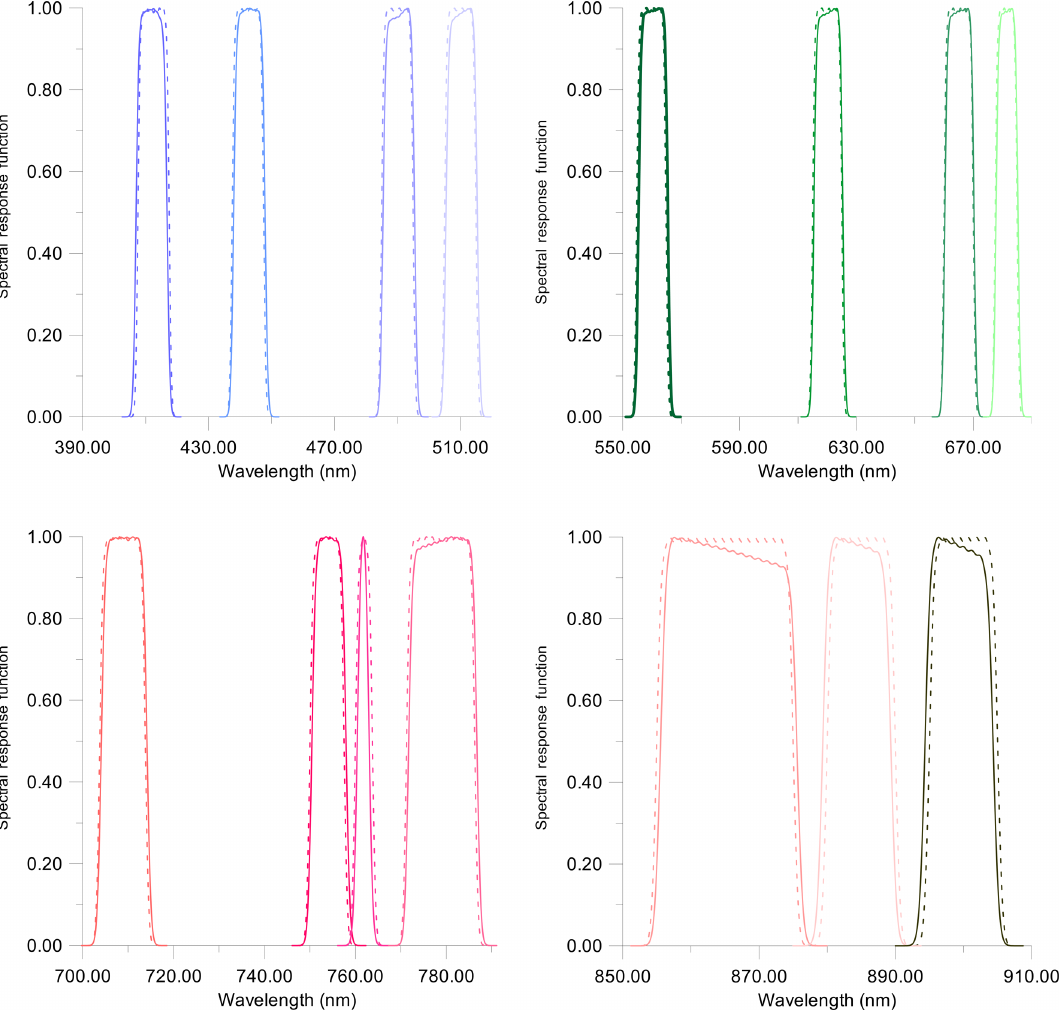
Figure 1. Spectral response function of MERIS (dashed lines) and OLCI (solid lines) for overlap